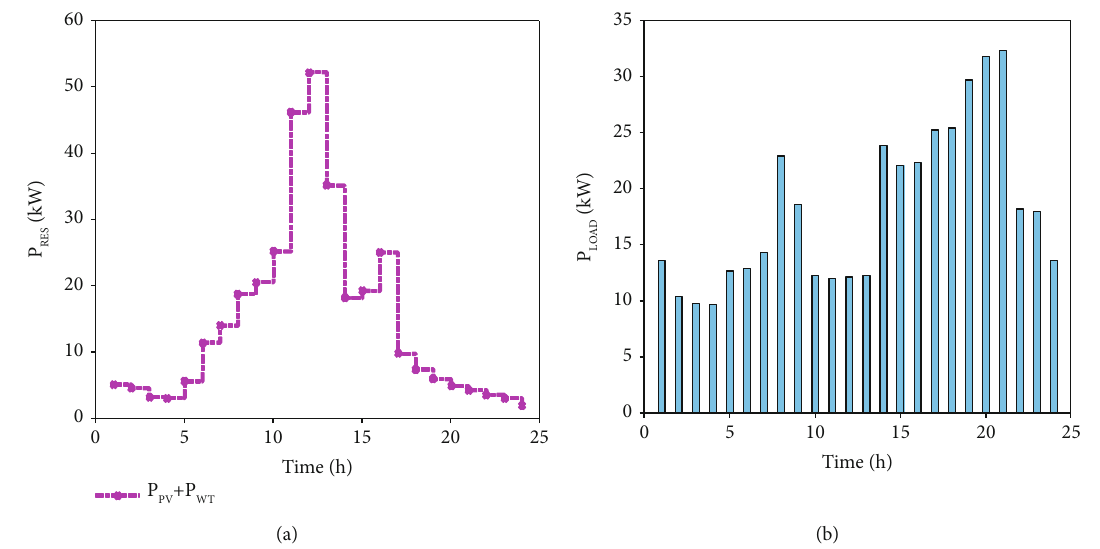
Figure 8: (a) PV and WT generation pro fi le for 24 h; (b) the power demand of the household for 24h.